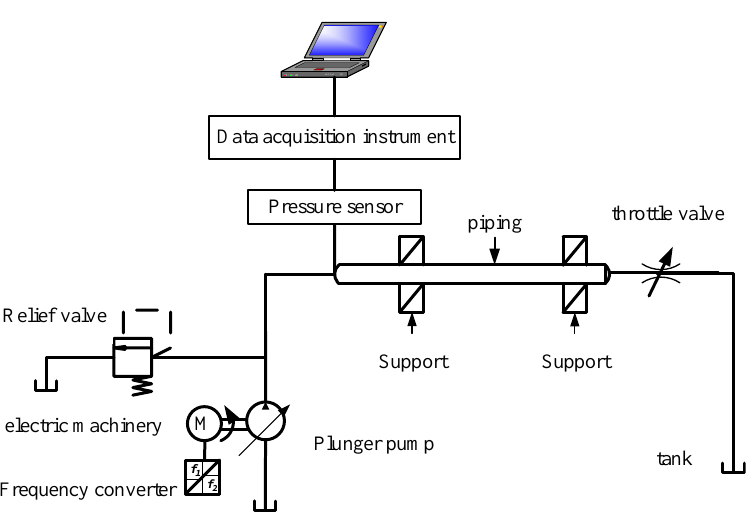
Figure 10. Schematic diagram of the pump source fluid pressure fluctuation test.